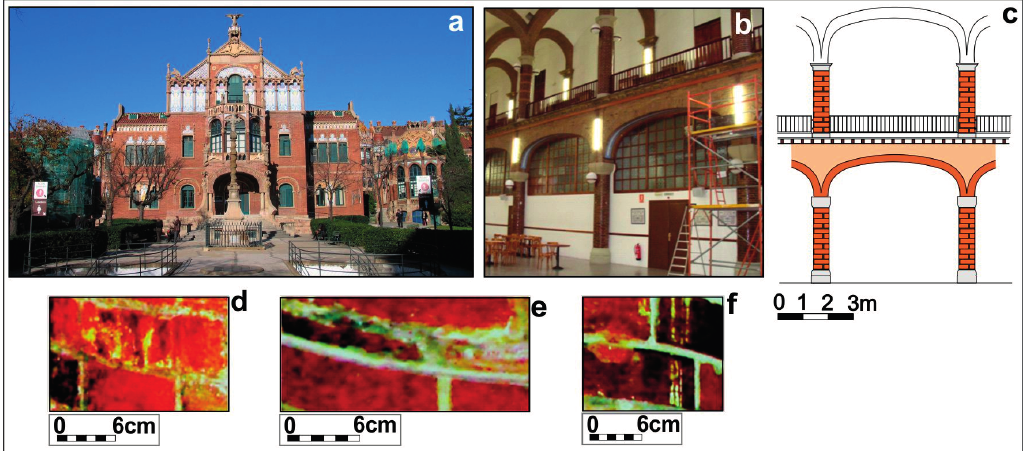
Figure 1. Hospital de Sant Pau i la Santa Creu. ( a ) View of the main façade; ( b ) internal view of one pavilion; ( c ) scheme of the supporting structures in the internal pavilion; ( d ) damage in columns caused by corrosion; ( e ) fissures in masonry columns; ( f ) moisture affecting the exterior of the